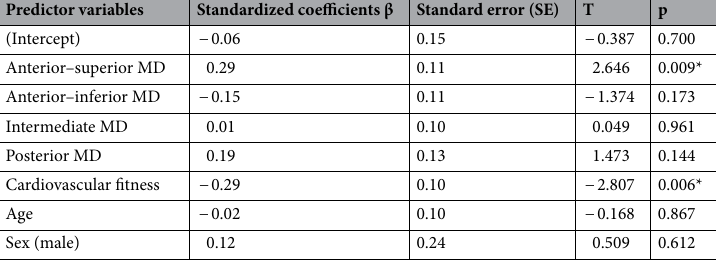
Table 3. Results of a multiple linear regression predicting BMI. MD mean diffusivity. *p <